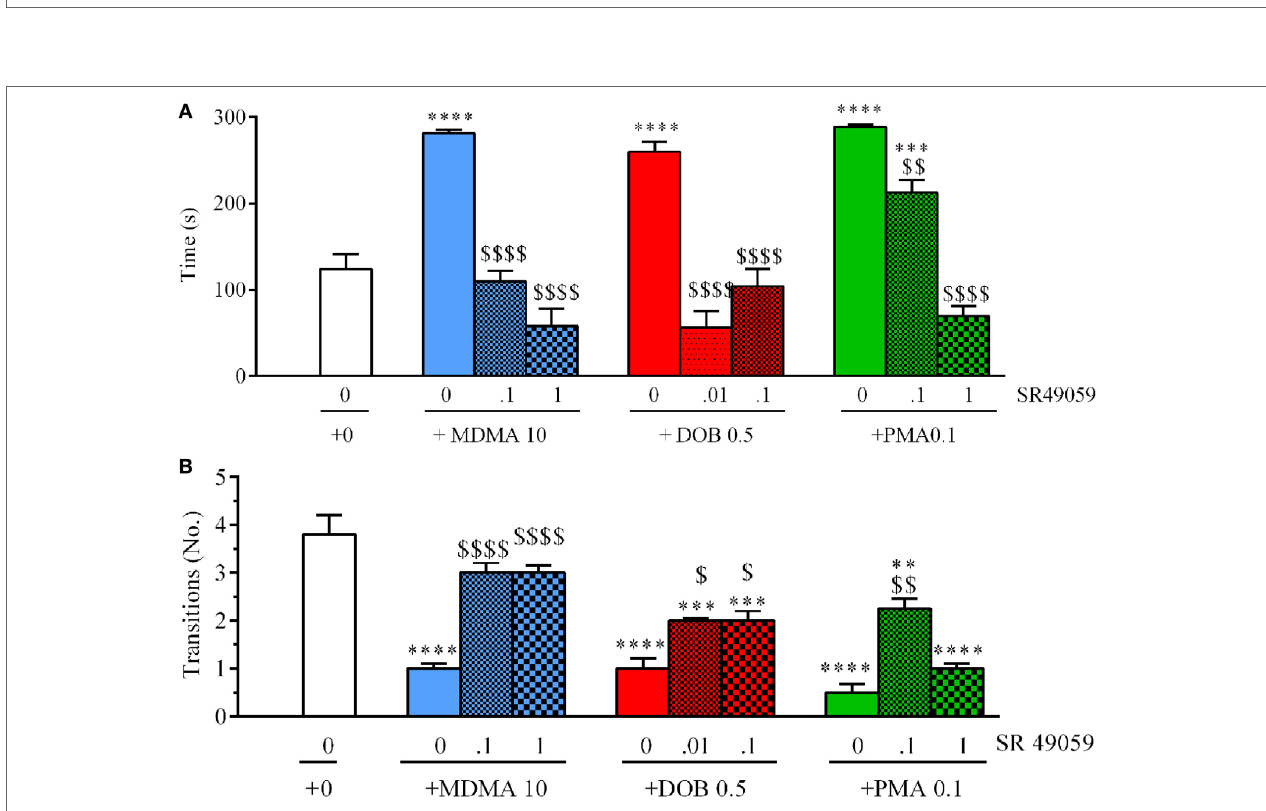
FigUre 5 | SR49050 dose-dependently reduces the anxiolytic effect induced by 3,4-methylenedioxymethamphetamine (MDMA), DOB, or para - methoxyamphetamine (PMA) in the novel tank diving test. The time spent in the upper half of the tank (a) and the number of transitions from the lower half to the upper half (B) were recorded during the 5-min sessions. The combination of SR49059 (ng/kg) or vehicle and each drug (mg/kg) was given intramuscularly (IM) immediately before the test. Mean values ± SEM; n = 10 fish per group. ** p < 0.01, *** p < 0.001, **** p < 0.0001 vs. the corresponding saline group (0 + 0); $ p < 0.05, $$ p < 0.01, $$$$ p < 0.0001 vs. the corresponding drug alone (Tukey’s post hoc test).